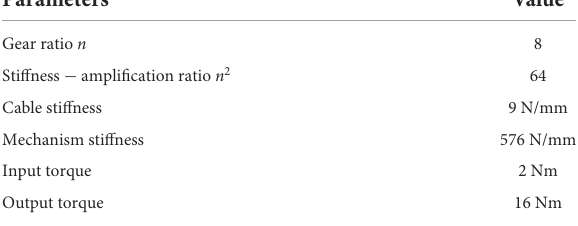
TABLE 2 Specification of high-stiffness tension-amplification